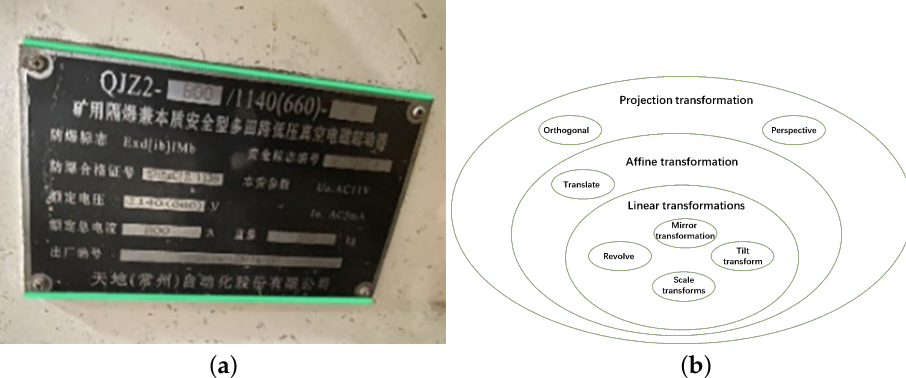
Figure 2. Process for correcting the uneven shape of industrial nameplates using the Probabilistic Hough Transform. ( a ) Find the edge in the image with the greatest length. ( b ) The relationship between projection transformation and its subsets. The double line segment obtained from the transform is used to extract four corners of the nameplate, which are then projected onto a rectangular shape based on their